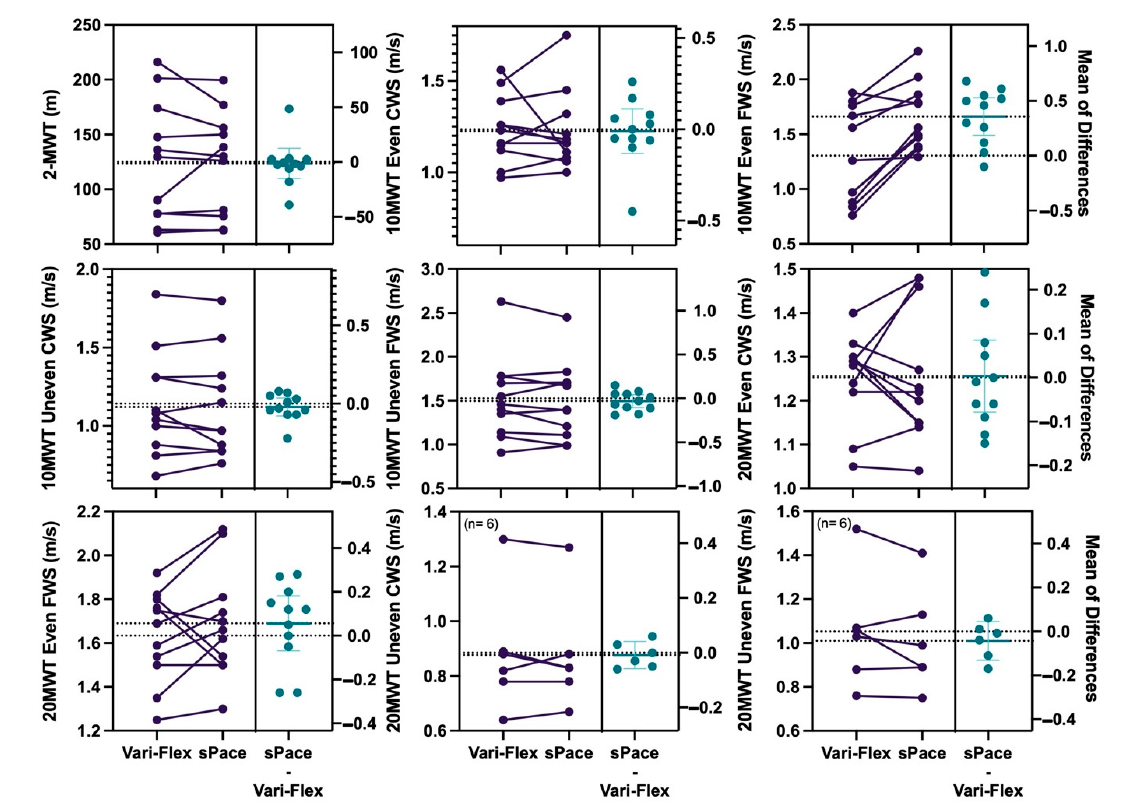
Figure 3. Panel of individual participant differences in outcomes when wearing sPace and Vari-Flex. Note: left panel: participant results between two feet; right panel: mean of differences. 2-MWT: two- minute walk test, 10MWT: ten-meter walk test, 20MWT: twenty-meter walk test, CWS: comfortable walking speed, FWS: fast walking speed, Even; even terrain, Uneven: uneven terrain, m: meters, m/s: meters per second. Table 1. Results of performance-based outcome measures in study participants wearing sPace and Vari-Flex feet.